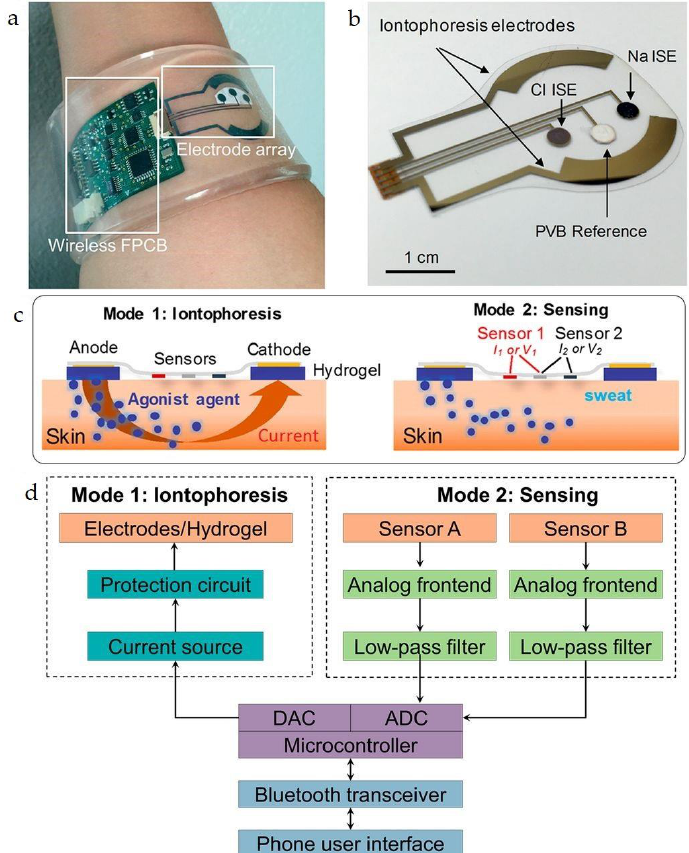
Figure 5. ( a ) Image of the sweat extraction and sensing platform; ( b ) Image of iontophoresis and sweat sensor electrodes for sodium and chloride ion sensing; ( c ) Schematic illustrations of the iontophoresis and sensing modes; ( d ) Block diagram showing the iontophoresis and sensing circuits. Reprinted from [35].